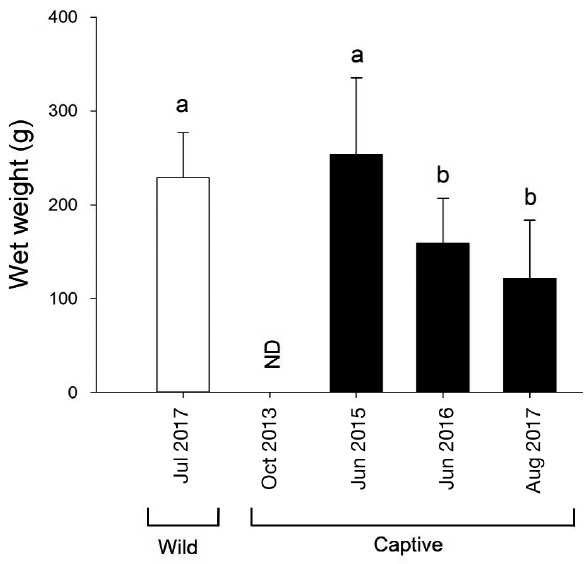
Fig. 1. Wet weight of wild individuals of Cucumaria frondosa (collected in 2017) and wet weight of captive individuals over time (2013−2017). Data are shown as means ± SD (n = 24 for wild and captive individuals in 2017; n = 40 for 2015 and 2016). Means with different letters are significantly different (Tukey’s test, p < 0.05). ND: not